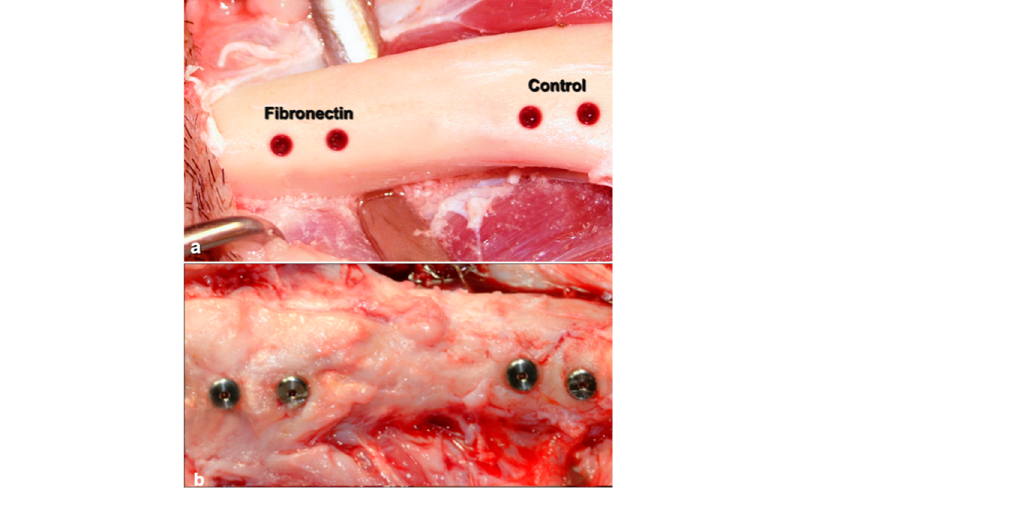
Figure 3. Example of implant site preparation: Untreated (control) or treated with Fibronectin ( a ). Implant sites, at 14 days, before sliced dissection ( b ).